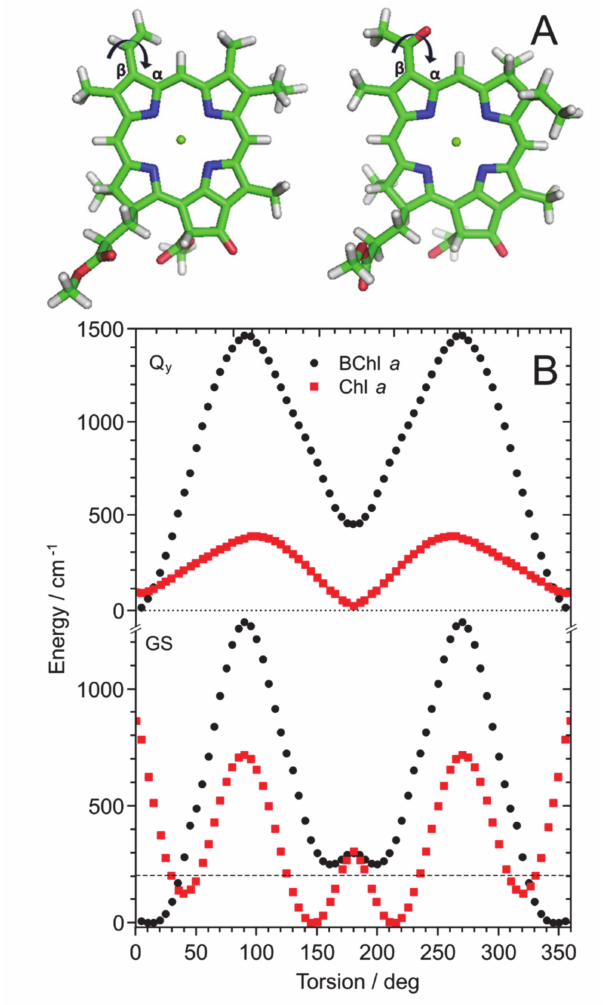
Figure 6. ( A ) The TD-DFT-CAM-B3LYP / 6-31G (d, p) optimized molecular structures of MeChlide a (left) and MeBChlide a (right), molecules used as model structures for Chl a and BChl a , respectively. ( B ) Dependence of the ground-state (GS) and Q y excited-state energies on the 3-vinyl / acetyl group torsion angle with respect to the cyclic tetrapyrrole π -plane (schematically indicated also in Figure 6A) in MeChlide a (red squares) and MeBChlide a (black dots) The horizontal dashed line shows the average thermal energy at ambient temperature: k B T = ~201.6 cm − 1 , where k B is the Boltzmann constant and T is the absolute